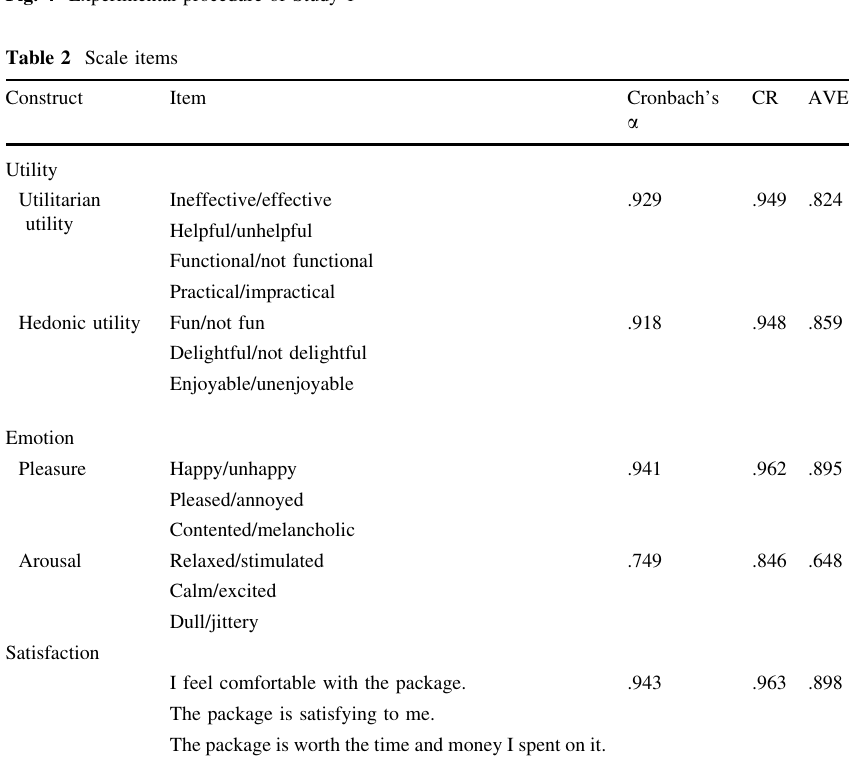
Fig. 4 Experimental procedure of Study